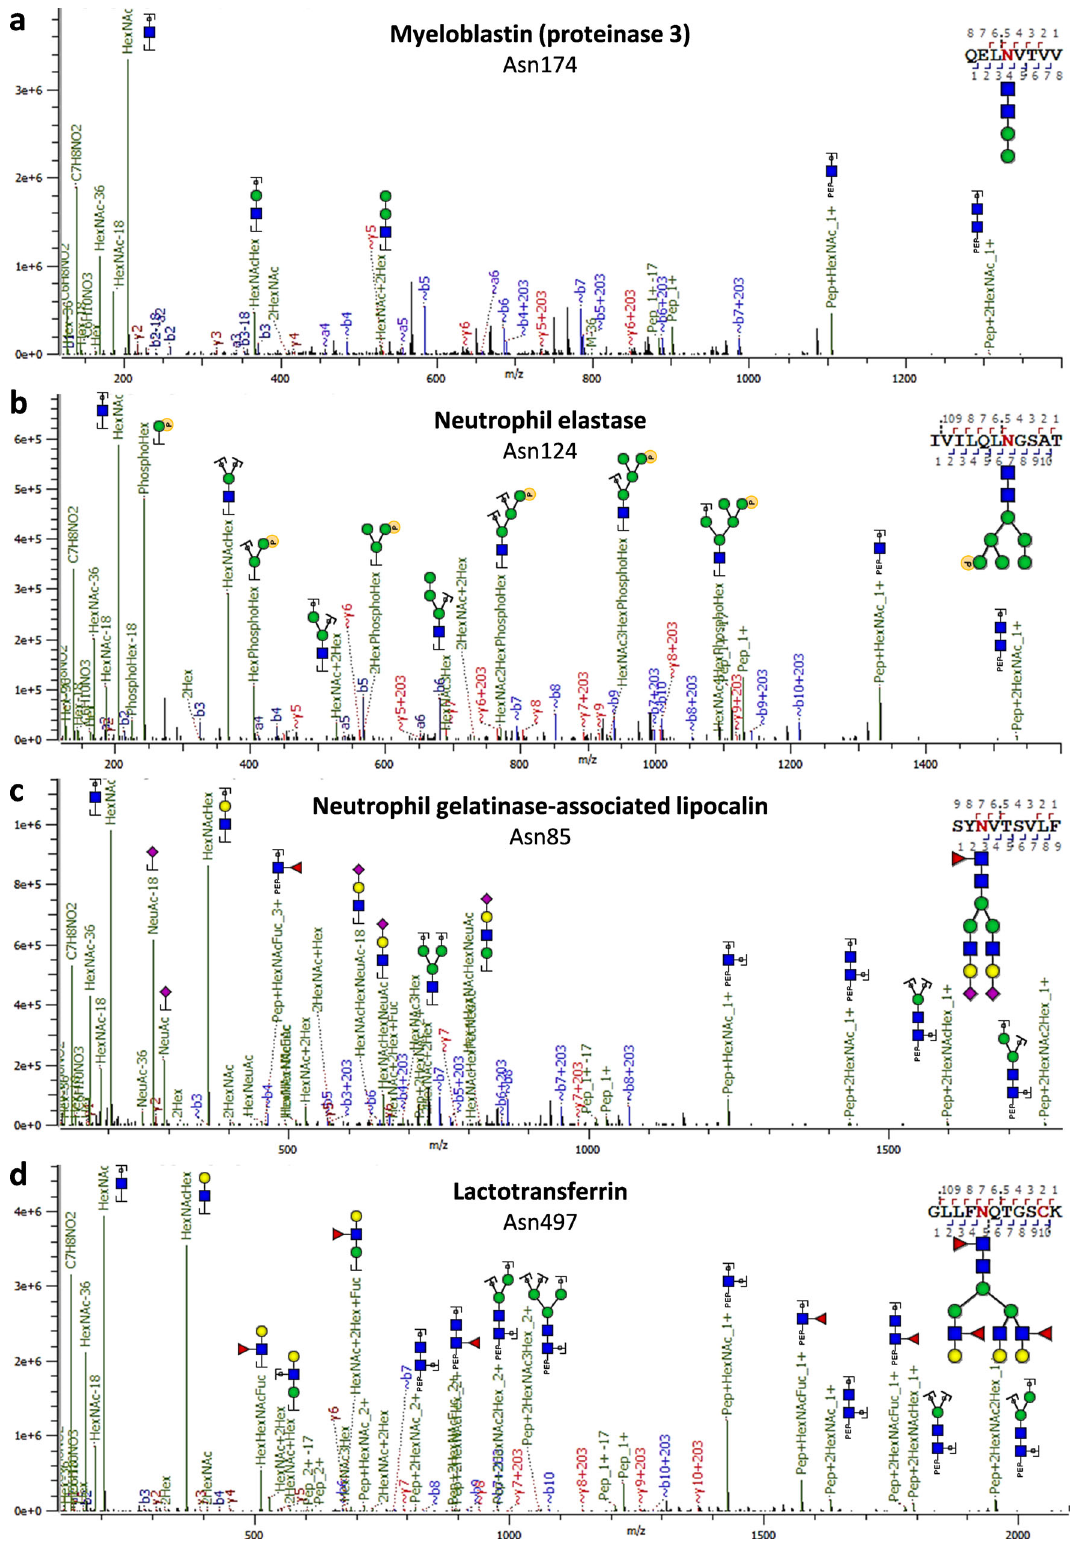
Fig. 3 Prototypical MS/MS spectra exemplifying the different categories of glycosylation observed in neutrophils. a Paucimannosylation, b phosphomannosylation, c sialylation, and d high degrees of (antennary) fucosylation. In a the fragments b4 + 203 and y5 + 203 position the paucimannosylated glycan unambiguously at the Asn residue, excluding that this peptide carries an O -glycan instead. Similarly, in b the phosphorylation clearly is associated with the hexose residues, excluding that is rather on the Ser or Thr residue. The glycoprotein and speci fi c site harbouring the modi fi cation is shown on the top of the spectrum. Fragmentation was achieved with higher-energy collisional dissociation (HCD).